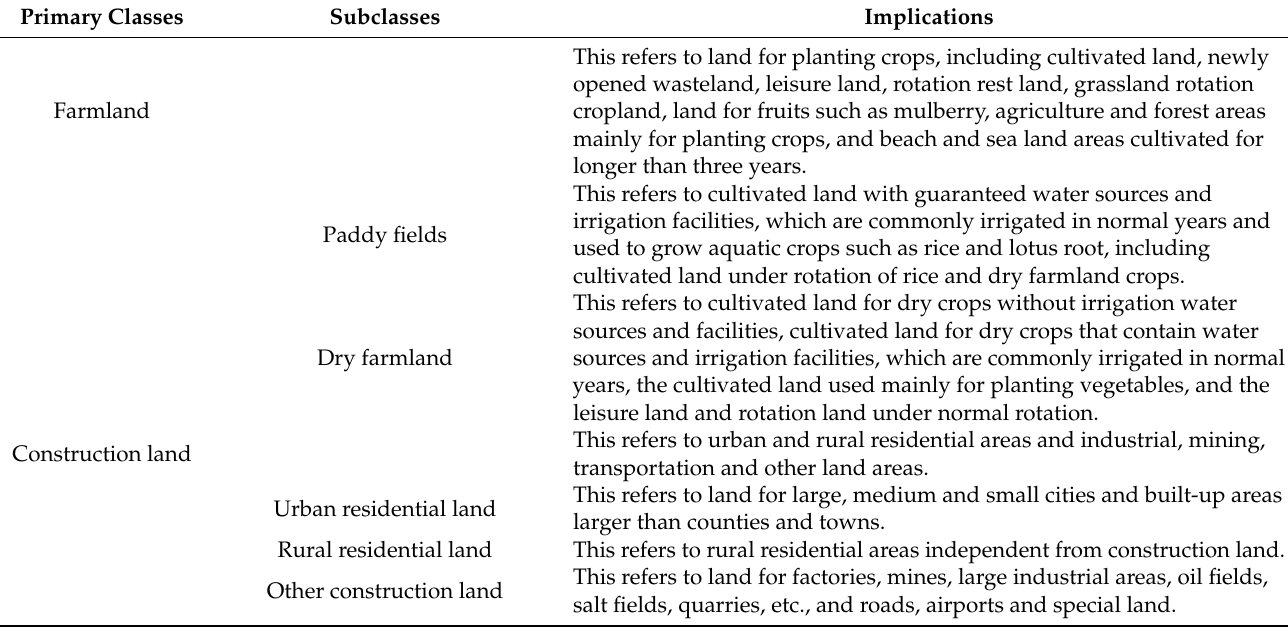
Table 1. Classification of farmland and construction land in this